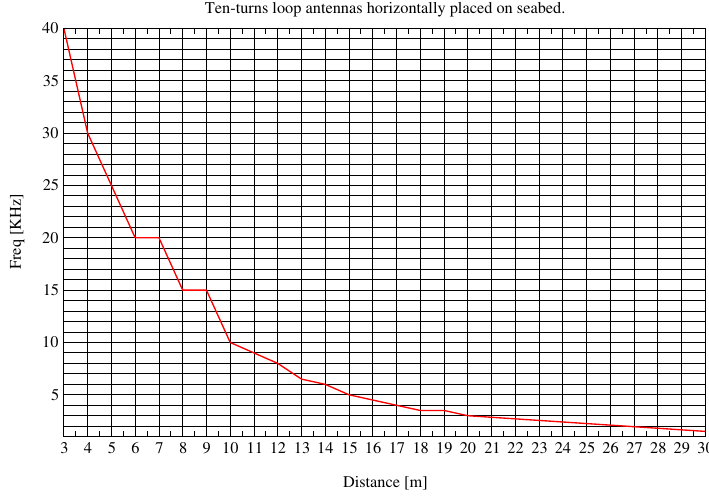
Figure 13. Optimum frequency for a given distance.